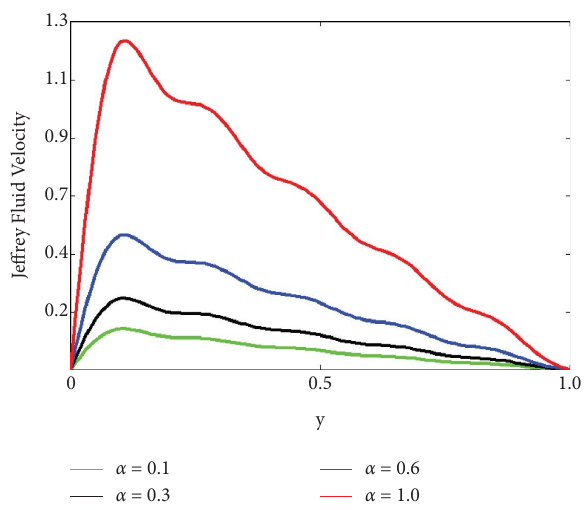
Figure 2: Te impact of diferent values of α on ψ ( y, t ) .